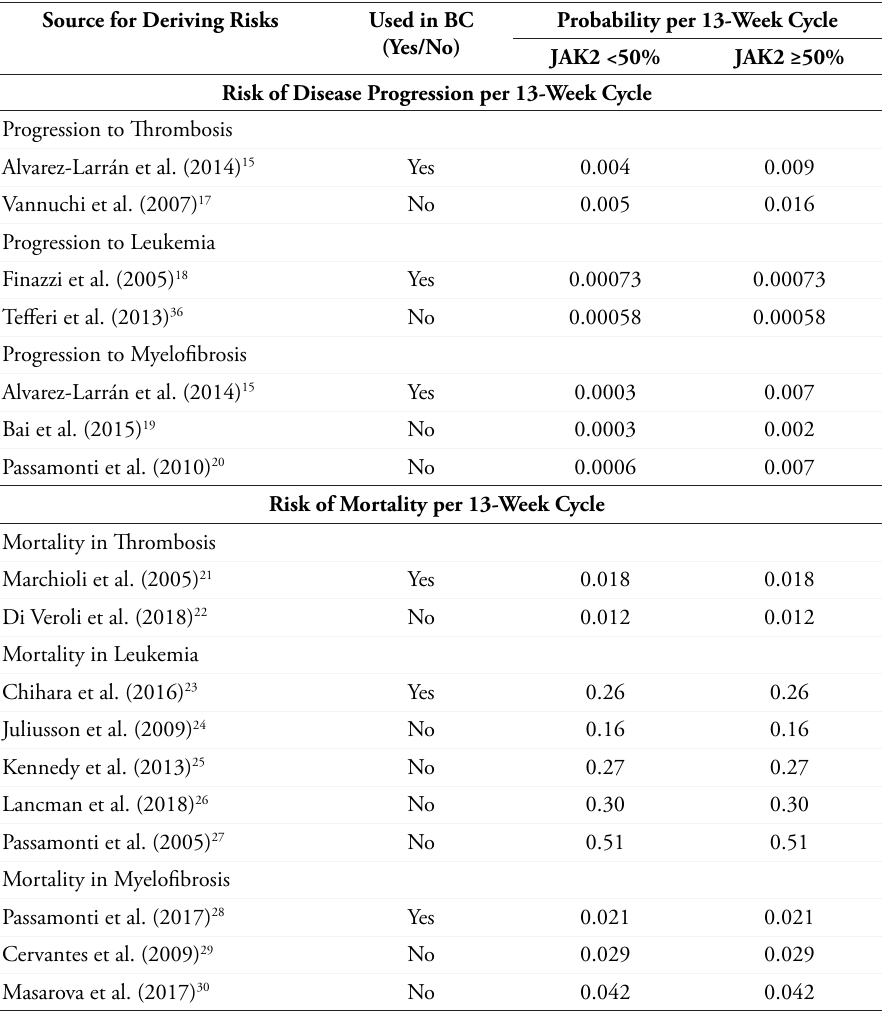
Table 1. Risk of Disease Progression and Mortality in Disease Progression for Data Used in BC Setting and Scenario